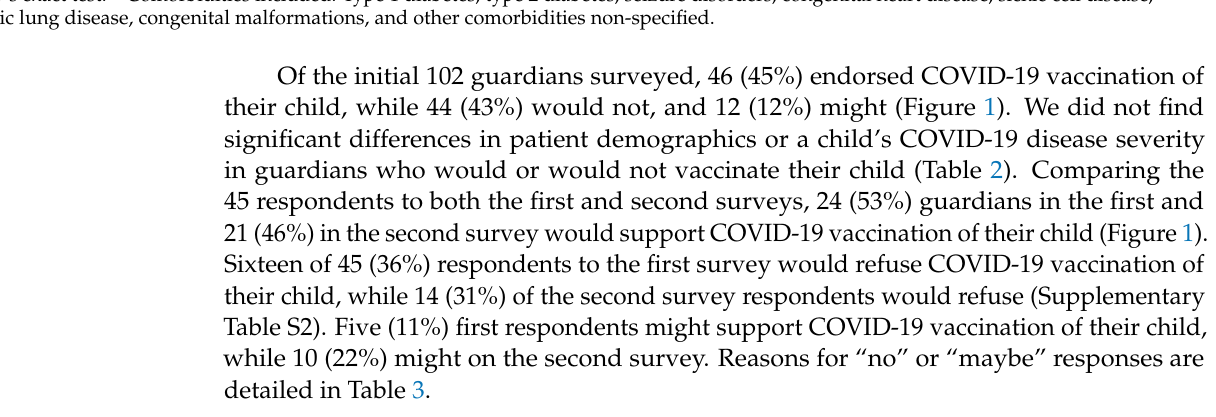
Table 2. Patient demographics by whether parent or guardian was vaccine-hesitant * at time of the primary